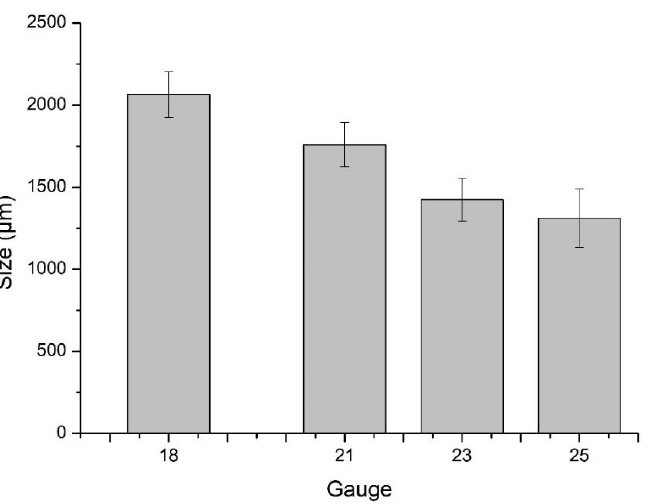
Figure 1. Microbead size variation with various syringe needle gauges. Error bars represent standard deviation (n = 50).